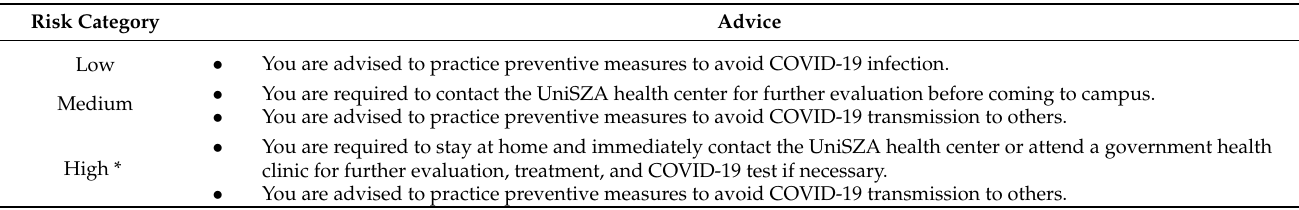
Table 2. Advice based on risk categories of the COVID-19